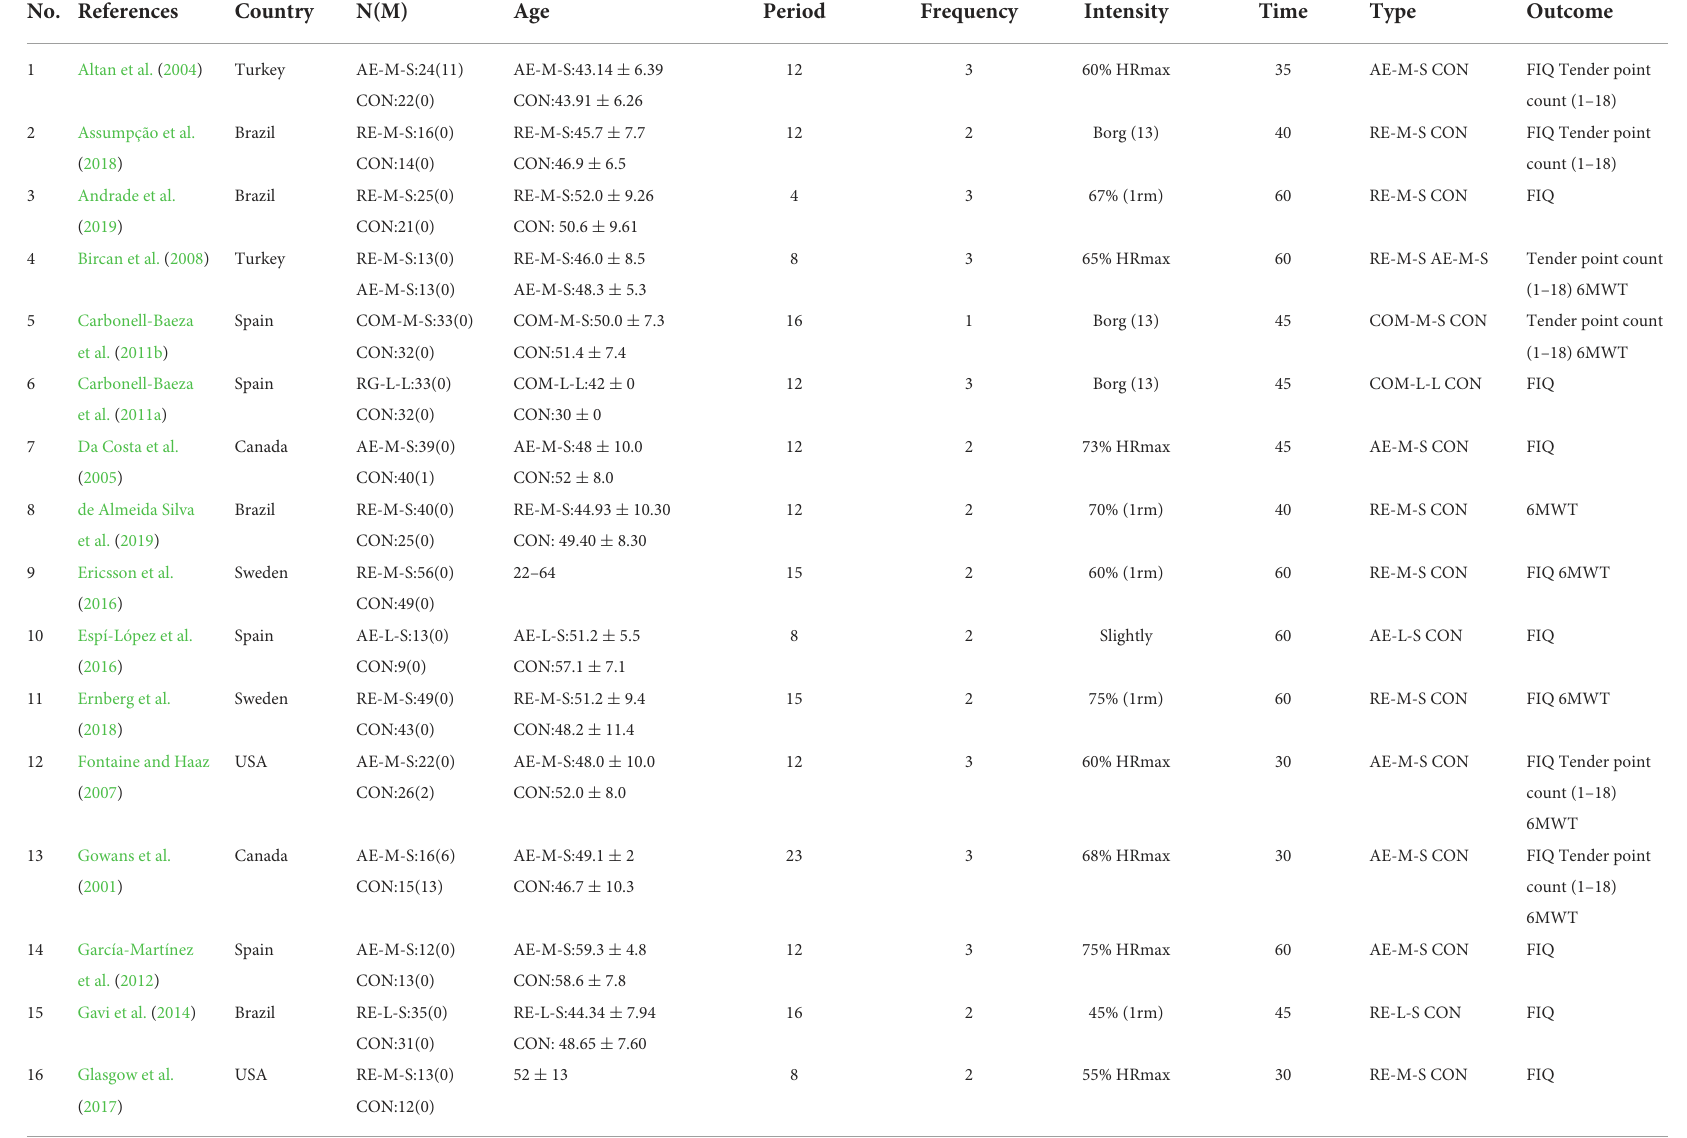
TABLE 2 Summary of studies included in network meta-analysis indicating the exercise intervention used and the outcome